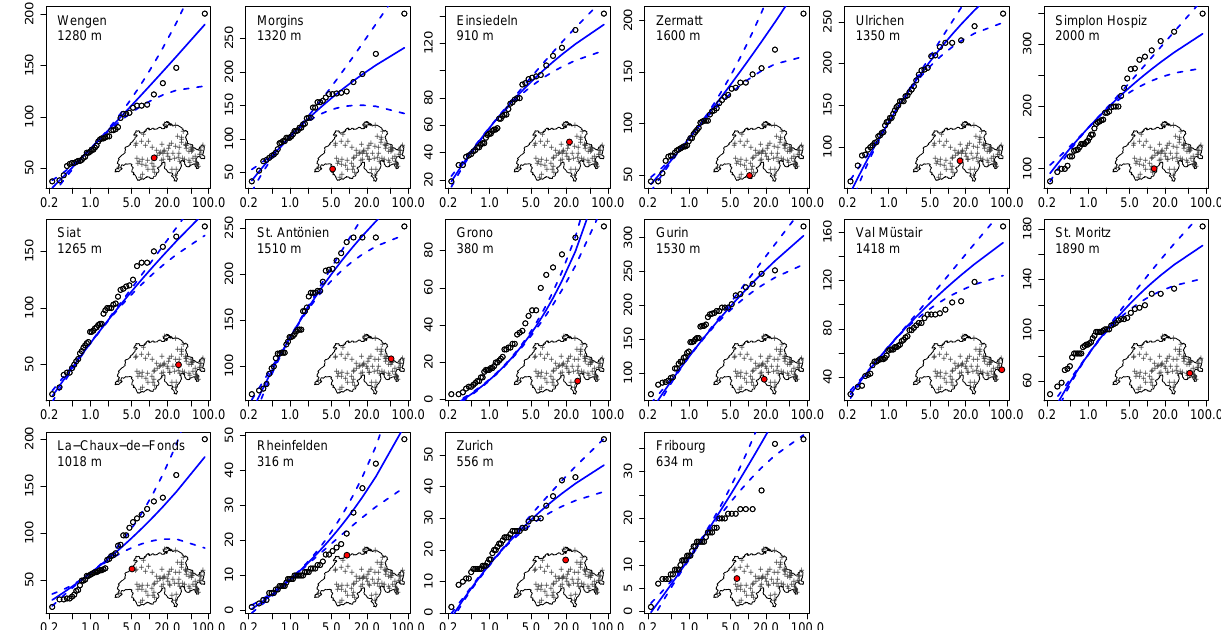
Fig. 7. Snow depth return level plots with the best smooth GEV model for the M = 16 validation stations, with 95% confident intervals (dotted lines). The kriged mean snow depth is used as an additional covariate. Red points in the Swiss map indicate the location of the station; its altitude is mentioned in the upper left corner. Crosses in the Swiss map locate the N = 84 stations used for fitting. Return levels (y-axis) are in centimeters (note the different scales among the plots); return periods (x-axis) are in years. new likelihood-based approach in which all stations have the same